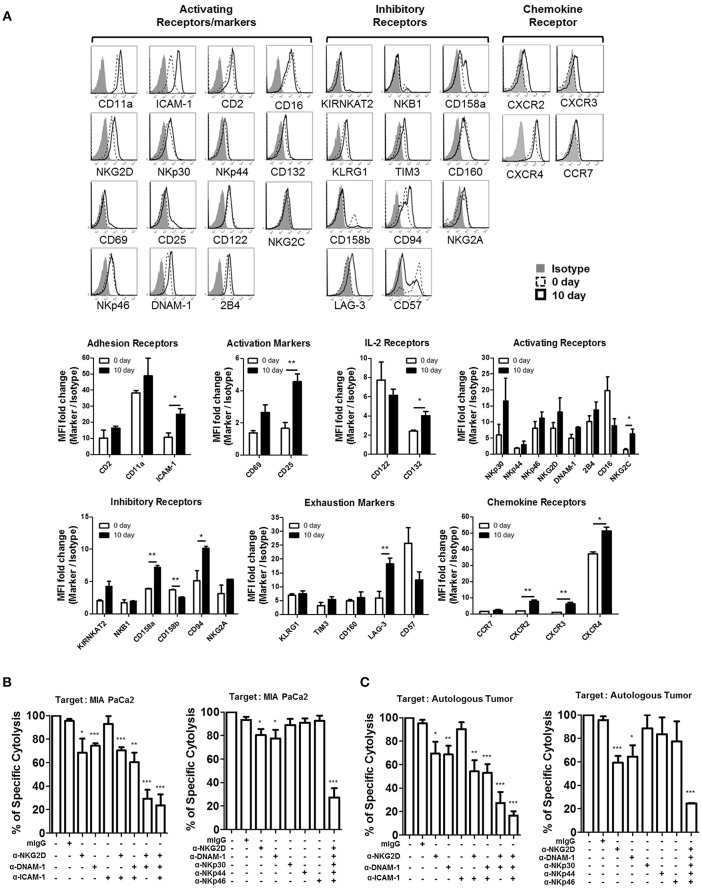
NKG2D and DNAM-1 are the main receptors responsible for killing autologous and allogeneic PDAC tumor cells. (A) Surface expression of multiple NK receptors was analyzed on CD3−CD56+ NK cells both prior to (dashed line), and 10 days after activation (solid line) using FACs. Isotype control is shown in gray. Data shown here are representative of five independent experiments. NK cell cytotoxicity assays against 51Cr-labeled MIA PaCa-2 (B) or autologous tumor cells (C), pre-treated with 5 μg/ml of anti-NKG2D, anti-DNAM-1, and anti-ICAM-1, are shown. Specific lysis after 4 h was plotted at E:T ratio of 1:1. Surface expression of NKG2D and DNAM-1 ligands in each tumor targets was analyzed by FACS (Figure S7). Error bars represent ± SEM. Statistical significance was determined by one-way ANOVA (*p ≤ 0.05; **p < 0.01; ***p < 0.001). Data shown here are representative of three independent experiments.